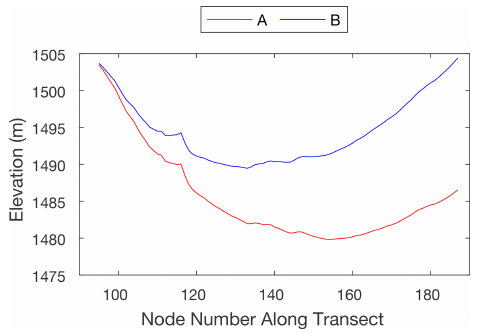
Figure A3. An example Lake 6 transect pair for photoclinometry calculations before (red) and after (blue)